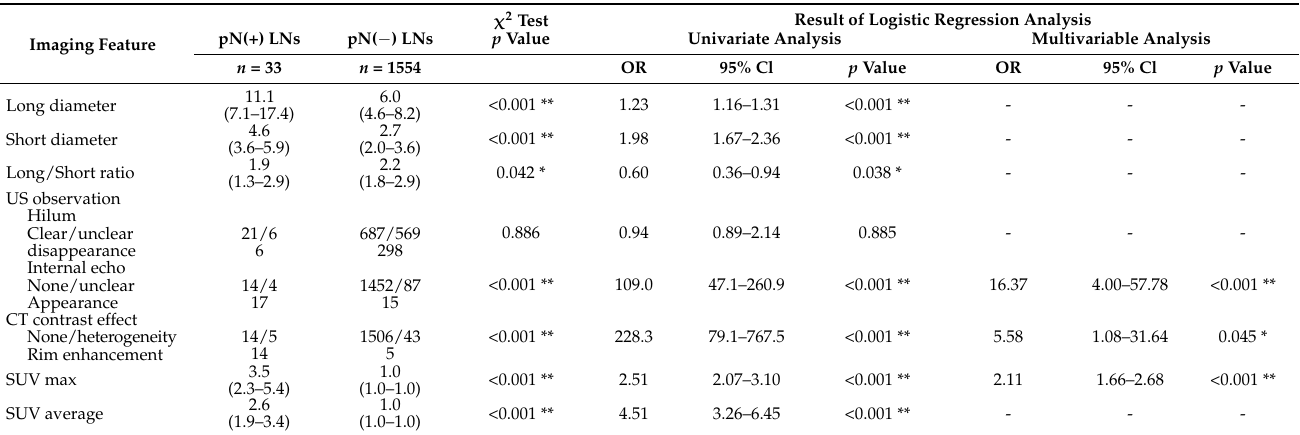
Table 2. Classification of imaging factors of lymph nodes and logistic regression analysis for imaging factors predicting lymph node metastasis.